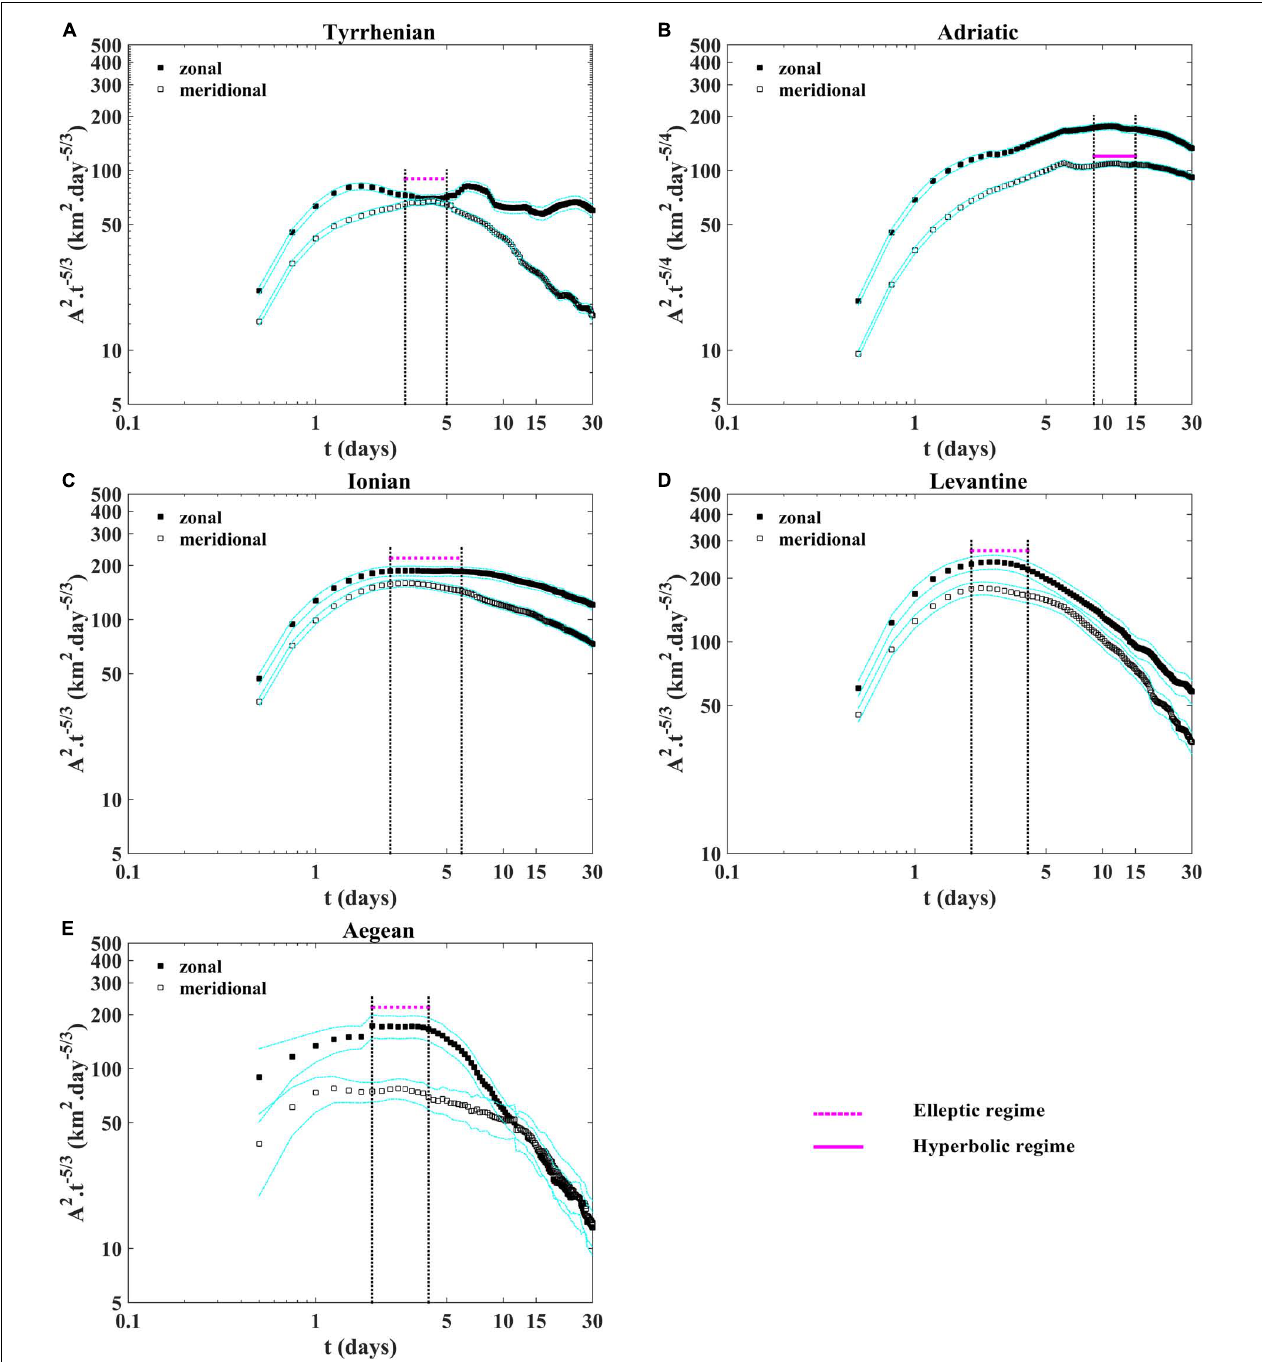
FIGURE 5 | Absolute dispersion for the zonal and meridional components normalized by t 5 / 3 as a function of time in loglog plot (A) in the Tyrrhenian, (C) the Ionian, (D) the Levantine (E) the Aegean and by t 5 / 4 (B) the Adriatic sub-basins. The horizontal magenta lines show the presence of plateau for the occurrence of the elliptic (dashed magenta line) and hyperbolic (magenta full line) regimes. The vertical dashed black lines show the time period of the anomalous regimes. The dashed cyan lines indicate the 90% confidence intervals from bootstrap resampling, give a rough idea of the uncertainties for the statistics.